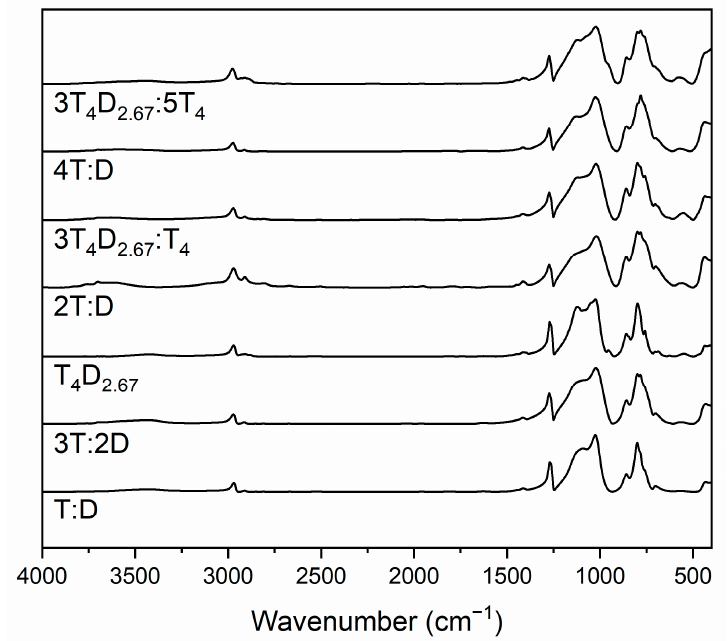
Figure 7. IR spectra of precursors.